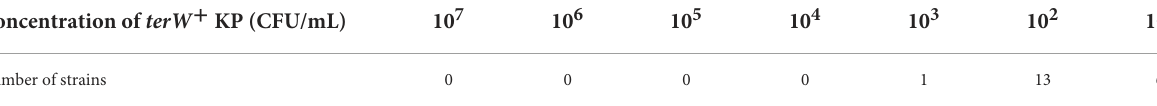
TABLE 4 Minimum concentration of bacteria that can grow in MCKT medium. Concentration of terW + KP